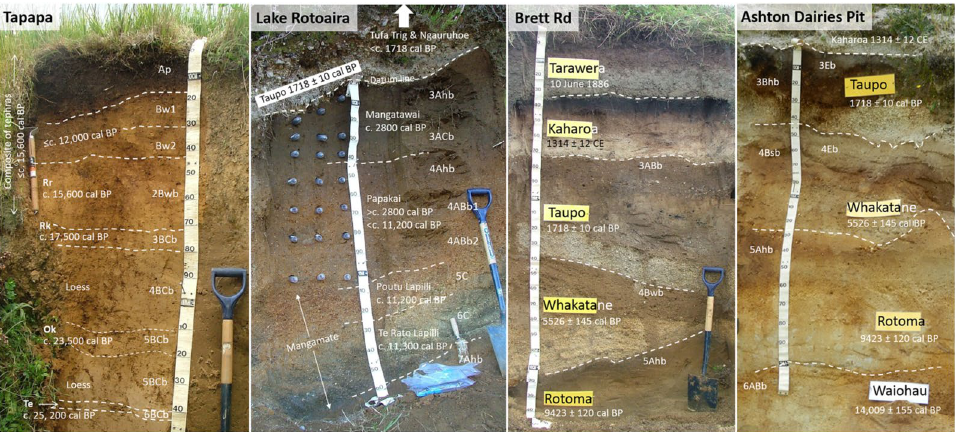
Figure 3. Photos of soil profiles showing soil horizons and their notation, and the stratigraphy and names and ages of parent tephras (ages were derived using tephrochronology) at Tapapa, Lake Rotoaira, Brett Rd, and Ashton Dairies Pit (Fig. 2). The suffix ‘b’ is used to denote an identifiable soil horizon with pedogenic features developed before its burial. Note that some of the buried soil horizons at Ashton Dairies Pit (3Eb, 3Bhb; 4Eb, 4Bsb) display morphologies associated with podzolization 2 . More details are given in Table 1 and Supplementary Sect. 1. Rr Rotorua tephra, Rk Rerewhakaaitu tephra, Ok Okareka tephra, Te Te Rere tephra, BP before present. For almost all of the Holocene, the soils carried a similar forest cover, namely podocarp-broadleaf forest